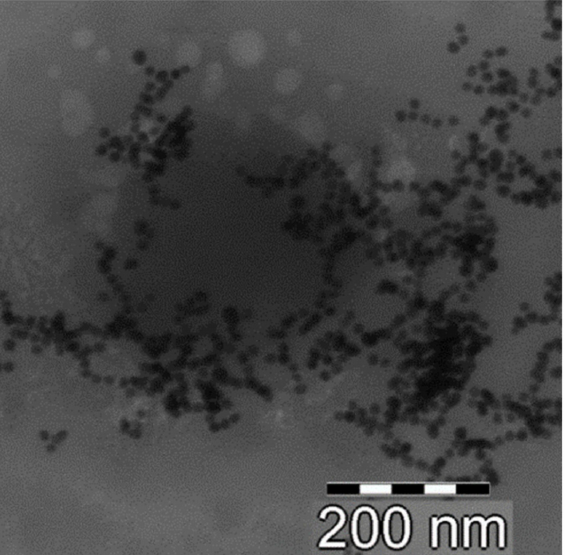
Figure 3. TEM picture of CS/HY NPs after incubation with a colloidal suspension of Au nanoparticles for 1